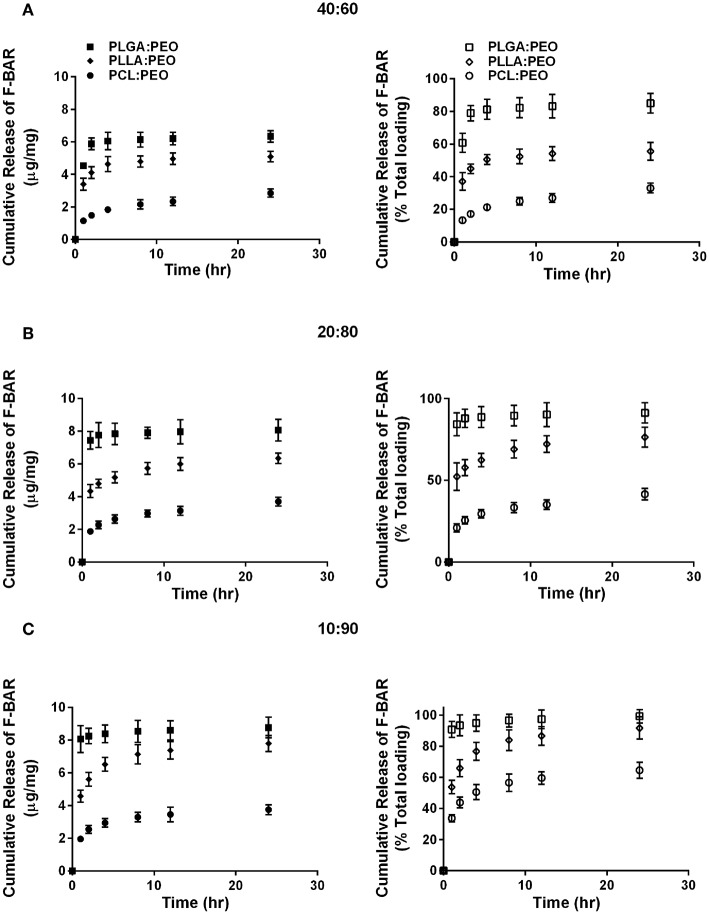
The cumulative release of F-BAR from 1% w/w F-BAR blended PLGA:PEO, PLLA:PEO, and PCL:PEO fibers (A) 40:60, (B) 20:80, and (C) 10:90. The cumulative release is reported as the total quantity of F-BAR released on the left (μg F-BAR per mg of fiber), and as the percent of total loaded F-BAR on the right. Error bars represent the mean ± the standard deviation (n = 3) of three independent experiments.